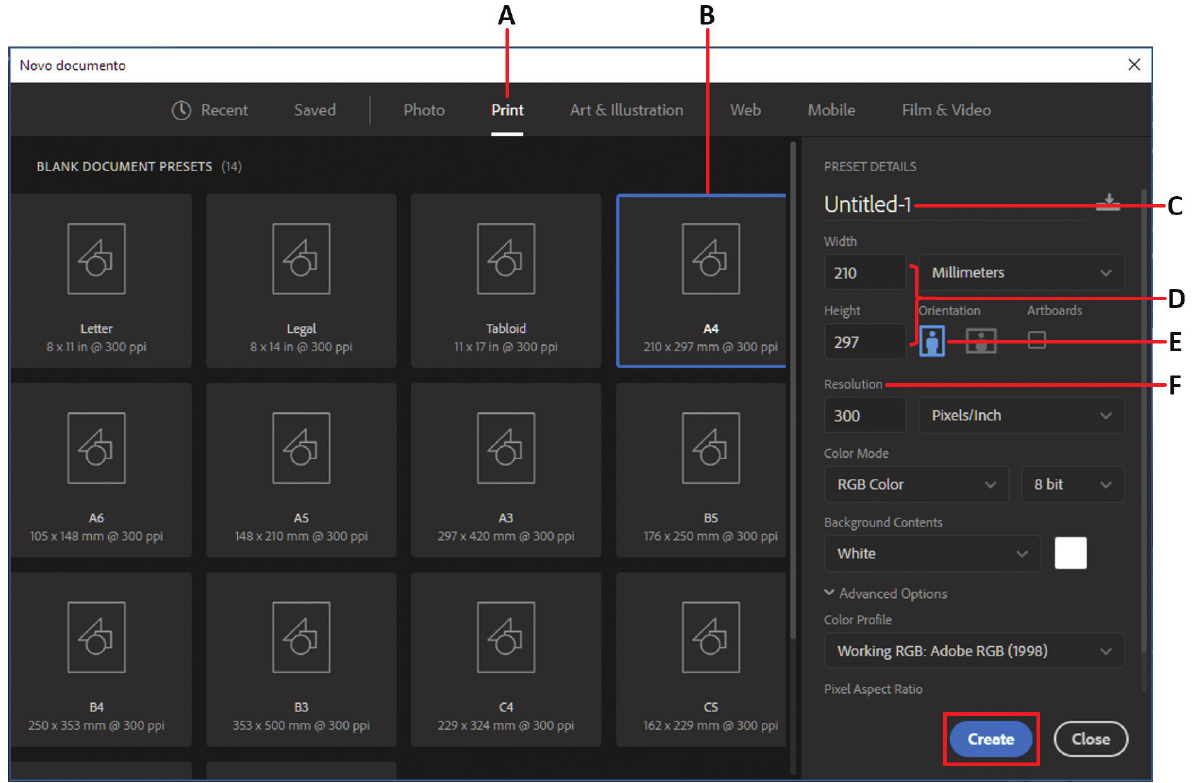
Figure 26. Create new document dialogue box. A . Guide containing some presets with document sizes; B . Selected document; C . The name of the file to be created; D . File dimensions (can be expressed in millimetres, centimetres, inches or pixels); E . Orien- tation of the document (portrait, landscape or square); F . Resolution of the document to be